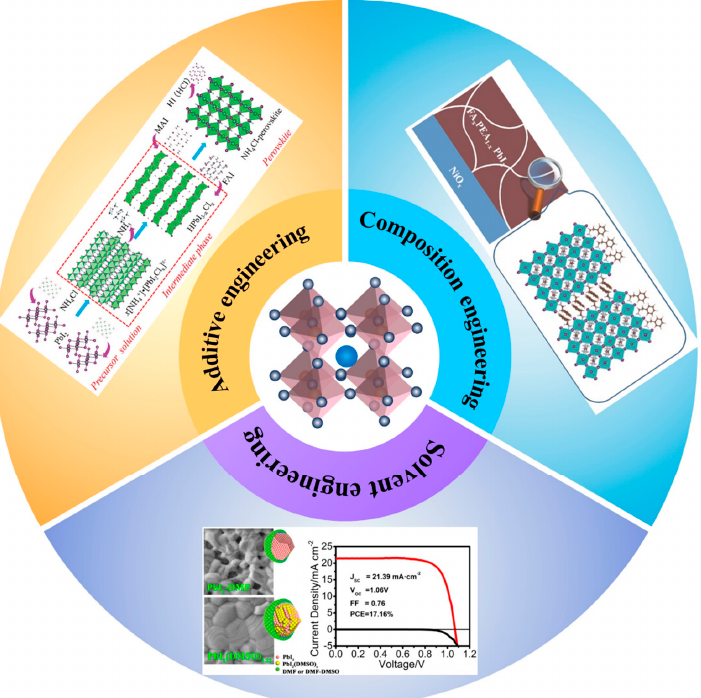
Figure 2. Different strategies for manipulating crystallization kinetics in two-step PSCs. Additive engineering image: reprinted with permission from [46]; copyright 2021, the authors; published by